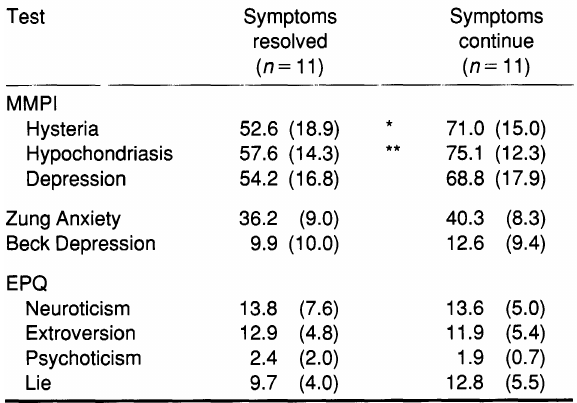
TABLE III. Mean scores (S.D.) of psychological tests according to outcome of clinical follow-up